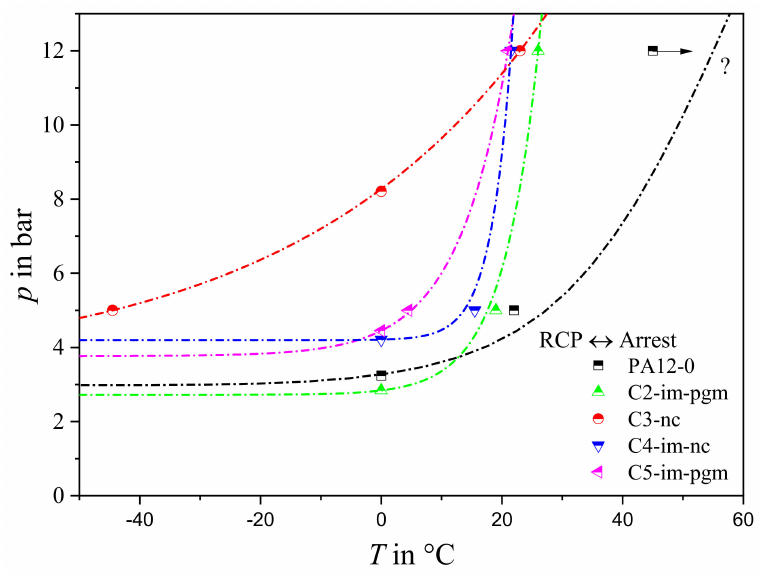
Figure 6. Rapid fracture behavior of PA12 grades as acquired from S4 tests according to the modified evaluation with predicted RCP/crack arrest transition